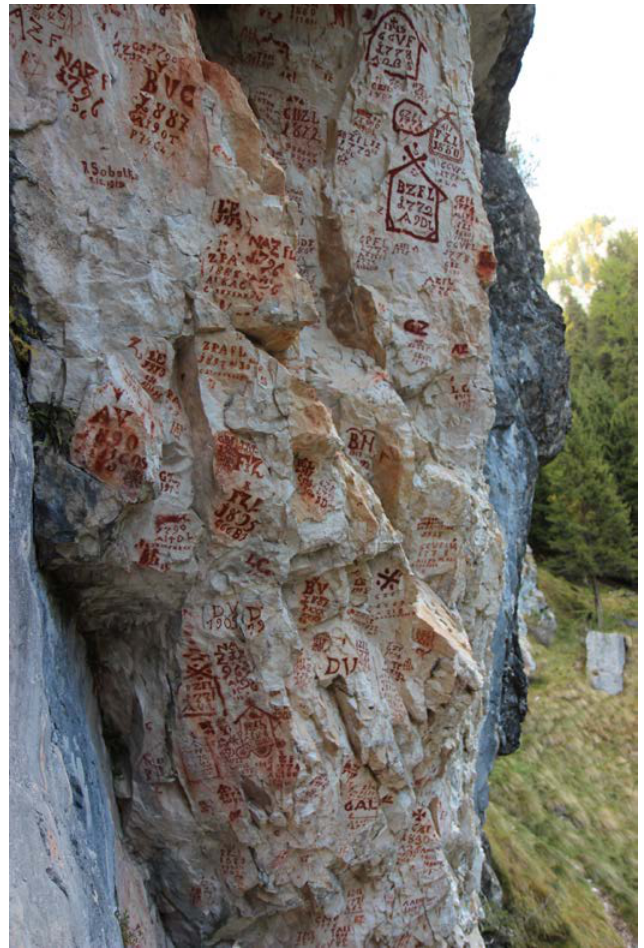
Figure 3 – Mount Cornón – Coròsso dai Nomi I : detail of the writings on the wall Courtesy of Museo degli Usi e Costumi della Gente